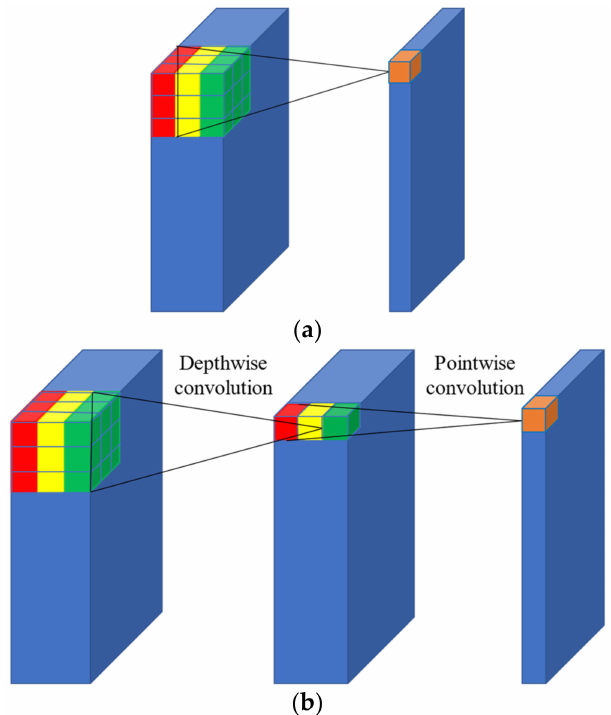
Figure 5. Comparison of convolution. ( a ) General convolution. ( b ) Depthwise separable